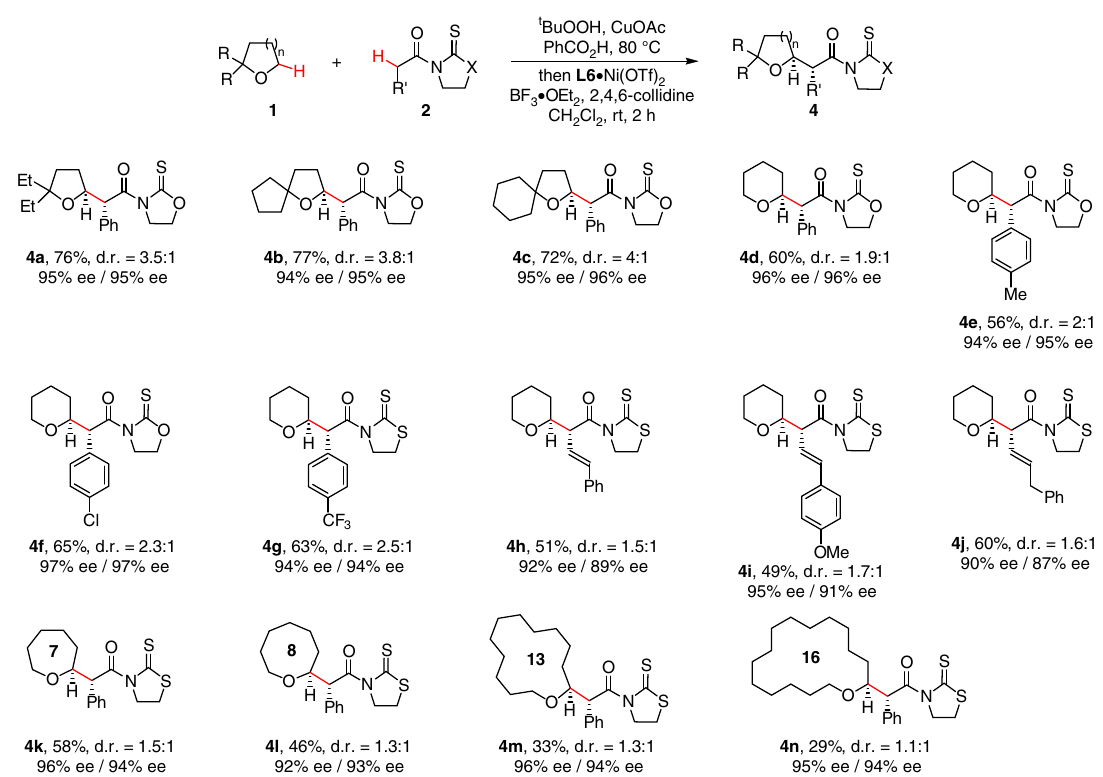
Fig. 3 The scope of cyclic saturated ethers. Conditions: PhCOOH (0.5 mmol, 2.5 equiv), CuOAc (2.5 mol%), t BuOOH in decane (3.0 equiv) in ether (1.0 mL) at 80 °C for 6 – 12 h, followed by 2 (1.0 equiv), L5·Ni(OTf) 2 or L6·Ni(OTf) 2 (10 mol%), 2,4,6-collidine (3.0 equiv), and BF 3 ·OEt 2 (4.0 equiv) in CH 2 Cl 2 (0.4 mL) at rt for 2 h